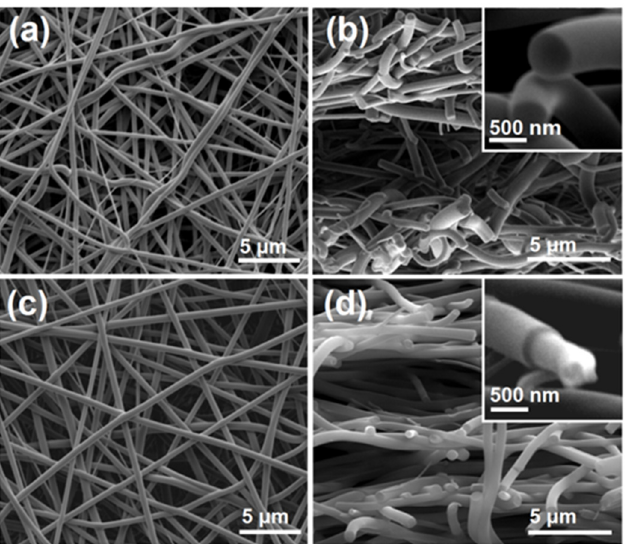
Figure 3. SEM images of the generated nanofibers: ( a , b ) the surface and cross-section morphology of the nanocomposites from the single-fluid electrospinning, respectively, the upper-right inset showing an enlarged image for the homogeneous composites; ( c , d ) the surface and cross-section morphology of the core–shell nanohybrids from the coaxial electrospinning, respectively, the upper-right inset showing an enlarged image for the heterogeneous hybrids.